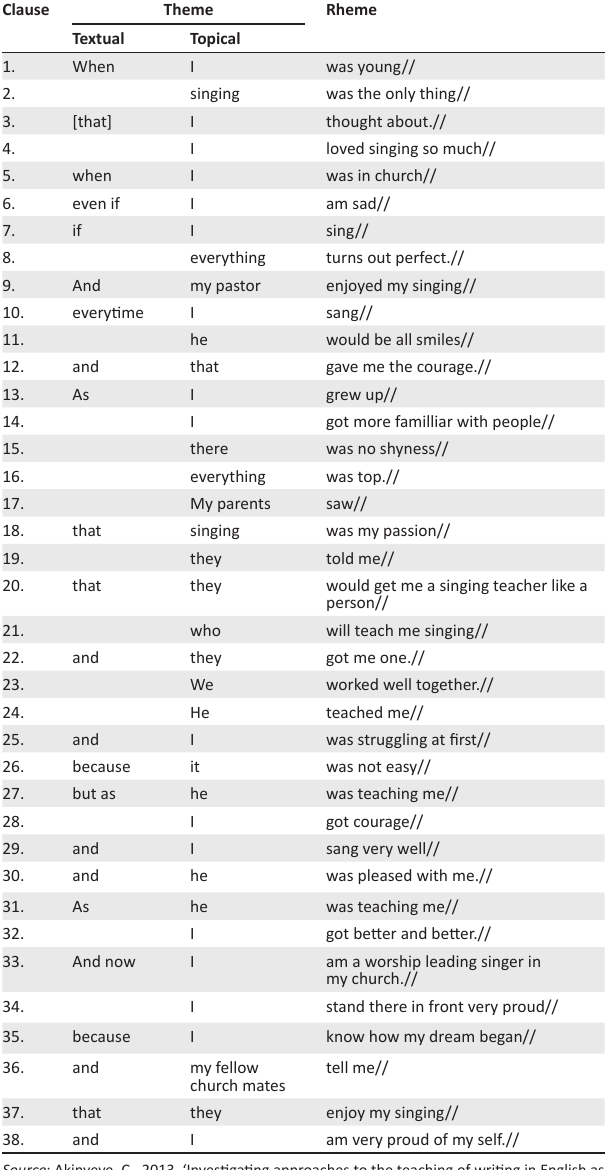
TABLE 1: Theme-rheme analysis of Zenobia’s final draft, with added clause